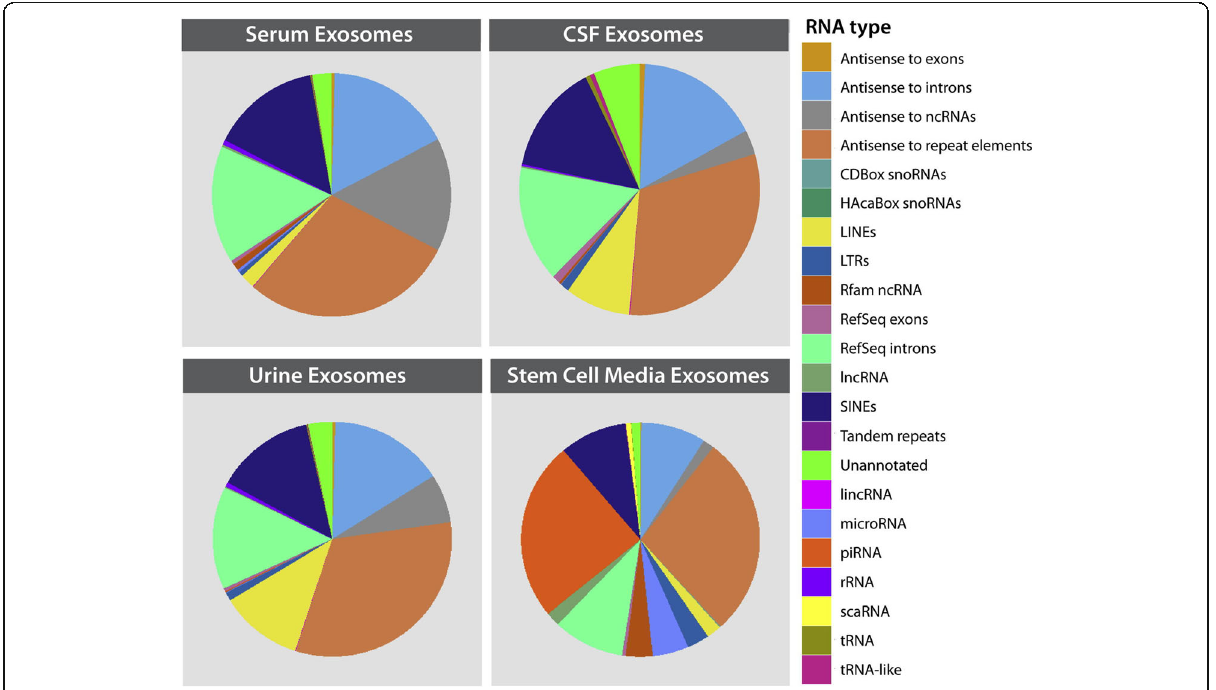
Fig. 10 The abundances and types of specific RNA classes present in exosome by NGS sequence [110]. Copyright© 2015 Elsevier Inc. All rights